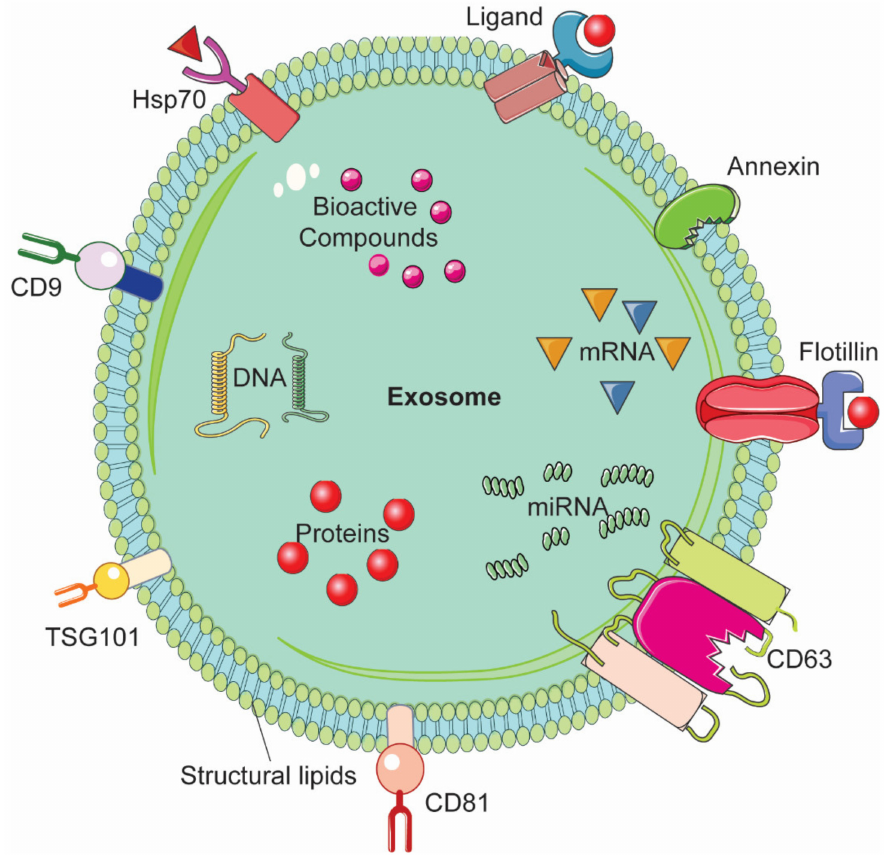
Figure 1. Representative structure of an exosome and its composition. The biogenesis of exosomes takes place by inward budding of the plasma membrane that forms the endosome vesicle, and the multivesicular bodies (MVBs). MVBs fuse with lysosomes and degrade or fuse with the plasma membrane and form exosomes which are released from cell into extracellular space (Figure 2A) [24,25]. They are released from various cell types like red blood cells, platelets, lymphocytes, dendritic cells (DCs), epithelial cells, adipocytes, fibroblasts, neural cells, stem cells, and cancer cells [26]. They have also been found in various biofluids such as blood, plasma, urine, cerebrospinal fluid (CSF), milk, amniotic fluid, malignant ascites, saliva, and synovial fluid [27–29]. They play a major role in cell-to-cell communication in the signalling pathways of both physiological and pathological processes [30], and transferring molecules such as proteins and RNA from donor cells to recipient cells [27,31]. Various specific proteins are present on the surface of exosomes, such as tetraspanin proteins (CD9, CD63, and CD81) [31], lysosomal protein (Hsp70), tumor sensitive gene 101 (Tsg101), and fusion proteins (annexin, and flotillin) [32]. These proteins are associated with the endosomal pathway, and are characteristic of exosomes, distinguishing them from MVs and ABs. MVs are another set of EVs with size in the range of 100–1000 nm; they are formed and released by budding off cell membrane [33]. In contrast, ABs are in the size range of 50–5000 nm, and are released